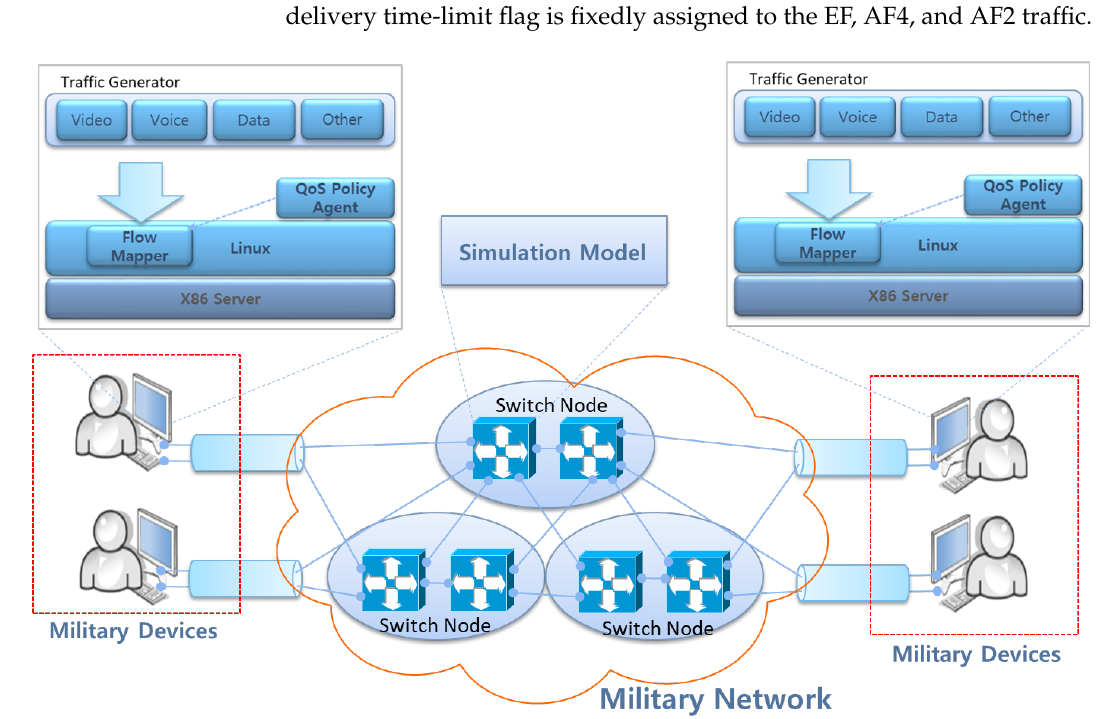
Figure 1. Switch node configuration of a military network.